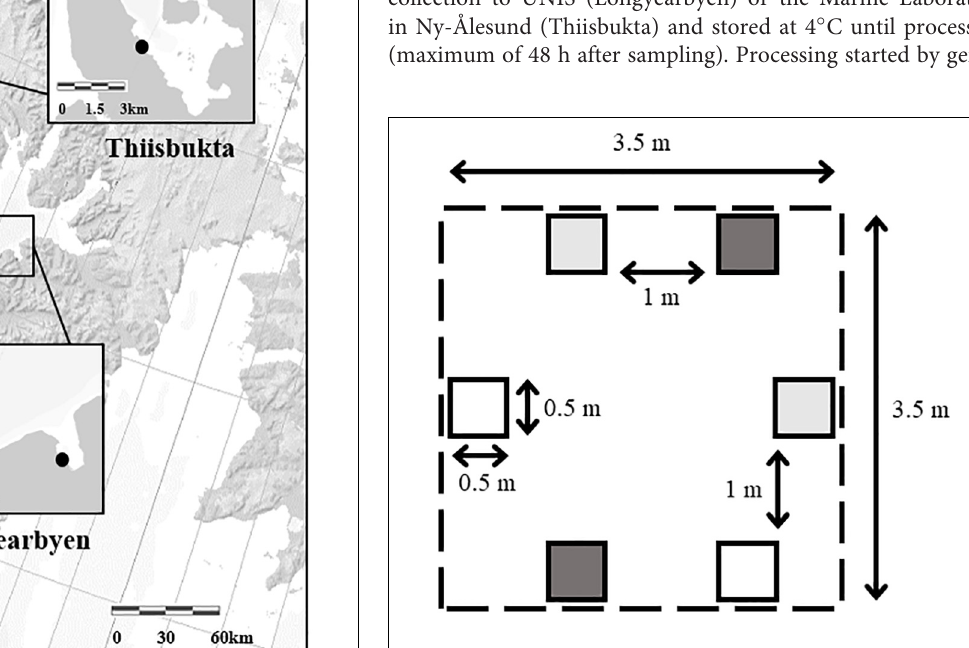
FIGURE 2 | Schematic spatial arrangement (not to scale) of a block hosting duplicate experimental units (quadrates) of each “Detached seaweed” treatment (dark gray), procedural control (light gray), and unmanipulated areas (white). Arrows with numbers indicate distances. Dashed line indicates intended block